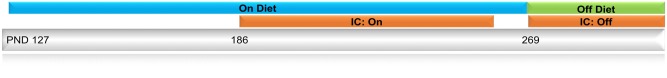
Experiment timeline.Rats received initial dietary exposure for 8-weeks (PND 127–182) before beginning the impulsive choice task on the diet (IC: On; PND 186). Following removal from the diet and transition to an all chow diet (PND 268), rats completed the impulsive choice task off the diet (IC: Off; PND 269).